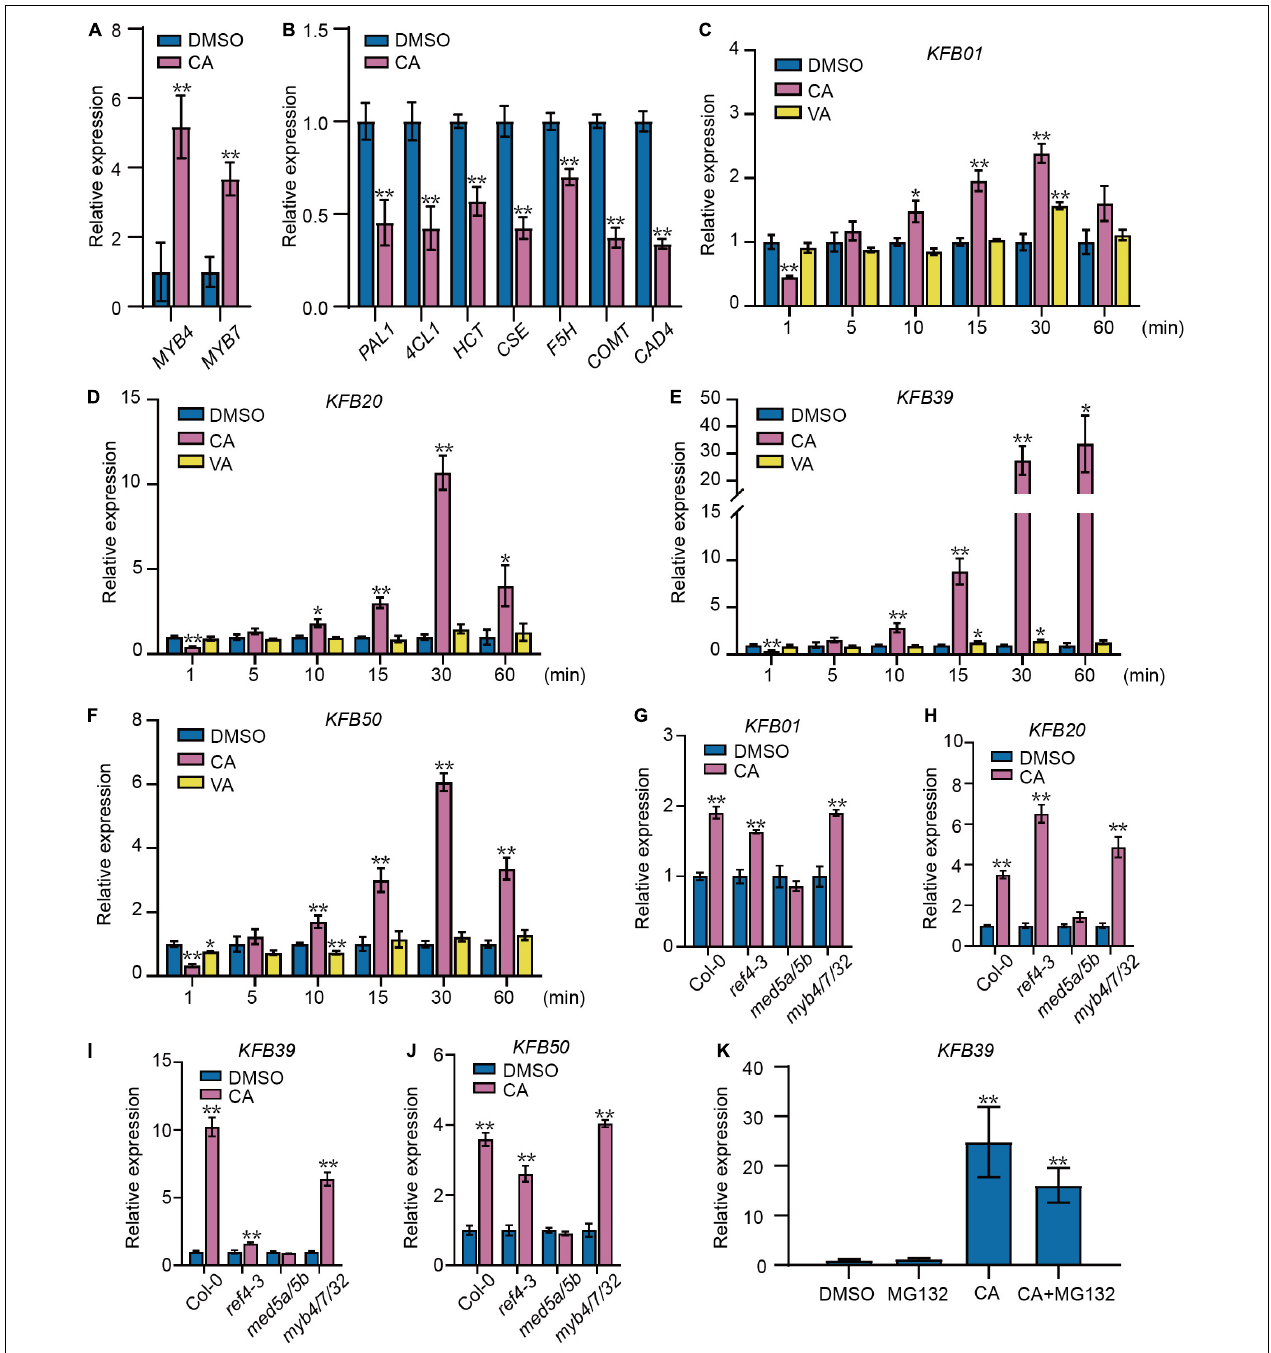
FIGURE 1 | Coniferyl alcohol acts as a signal molecule to regulate the phenylpropanoid pathway. (A) The expression of MYB4/7 was induced by coniferyl alcohol (CA). The transcript levels of MYB4/7 were assayed in 2-week-old Col-0 seedlings treated with solvent DMSO or 0.1 mM CA for 15 min. (B) Relative transcript levels of lignin biosynthetic genes are decreased after CA treatment. The transcript levels of PAL1 , 4CL1 , HCT , CSE , F5H , COMT, and CAD4 were assayed in 2-week-old Col-0 seedlings treated with solvent DMSO or 0.1 mM CA for 4 h. qRT-PCR assays of KFB01 (C) , KFB20 (D) , KFB39 (E), and KFB50 (F) in Col-0 seedlings. (C–F) Two-week-old Col-0 seedlings were separately treated with solvent DMSO, 0.1 mM VA (vanillyl alcohol) or 0.1 mM CA for different time intervals. qRT-PCR assays showing the expression of KFB01 (G) , KFB20 (H) , KFB39 (I), and KFB50 (J) in response to CA in Col-0, ref4-3, med5a/5b and myb4/7/32 seedlings. (G–J) Two-week-old seedlings were treated with solvent DMSO or 0.1 mM CA for 15 min. (K) The induction of KFB39 expression by CA does not rely on proteolysis. The transcript level of KFB39 after 1 h treatment with 0.1 mM CA with or without 60 µ M MG132 in 2-week-old Col-0 seedlings. All data represent average transcript level values ( ± SD) relative to DMSO-treated plants. Asterisks indicates a statistically significant difference between the treated and DMSO control groups (Student’s t -test, * P < 0.05, ** P < 0.01, n = 3).